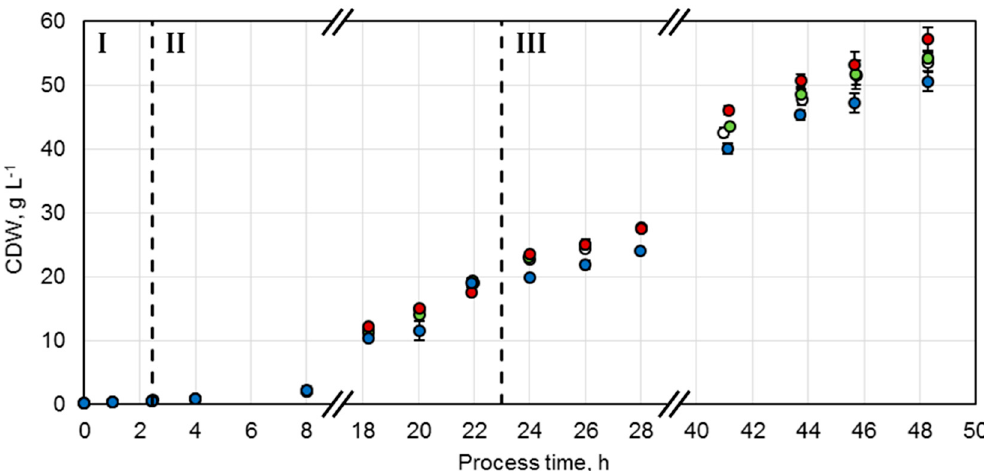
Figure 2. Cell dry weight (CDW) concentrations of fed-batch cultivations of E. coli BL21 (DE3) with constructs NostocER1-FDH ( ○ ), Loop 1,2a-FDH ( ● ), Loop 1,5-FDH ( ● ), and Loop 1,5,2a-FDH ( ● ) in a stirred-tank bioreactor on an L-scale. The vertical dotted lines separate the biomass production in the batch phase (I), the fed-batch phase (II), and the enzyme production phase (III). All values represent means ± standard deviation of triplicate determinations.